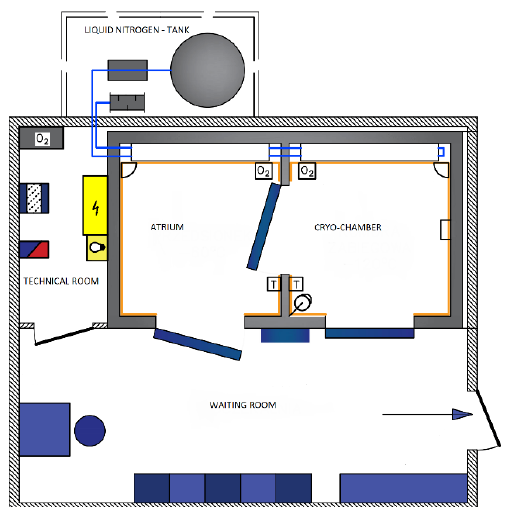
Figure 2. General diagram of a cryochamber (according to CREATOR Sp. z o.o).